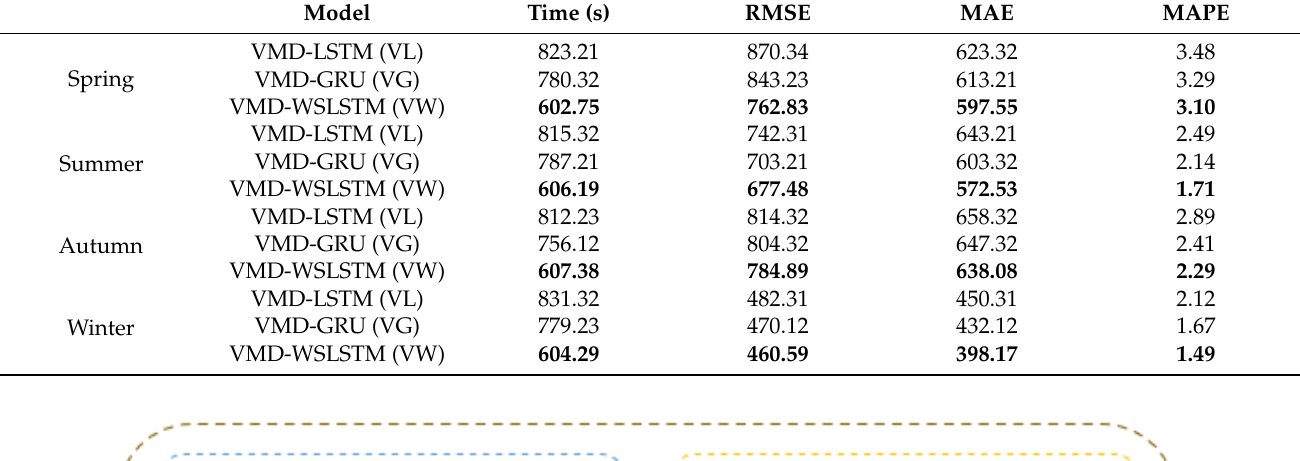
Table 8. Forecast results of different forecasting methods (the best results of each model are bolded).